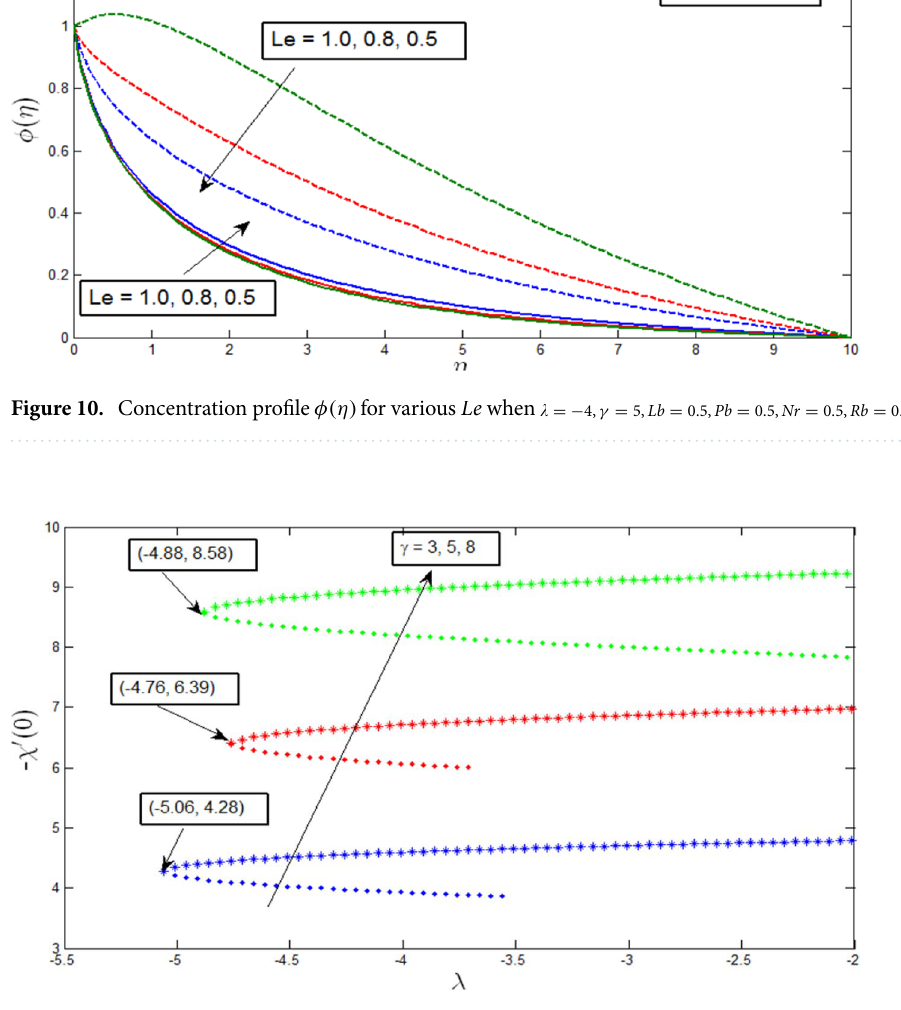
Figure 11. Microorganism transfer rate − χ Pb = 0.5, Le = 1, Nr = 0.5, Rb = 0.6, A =